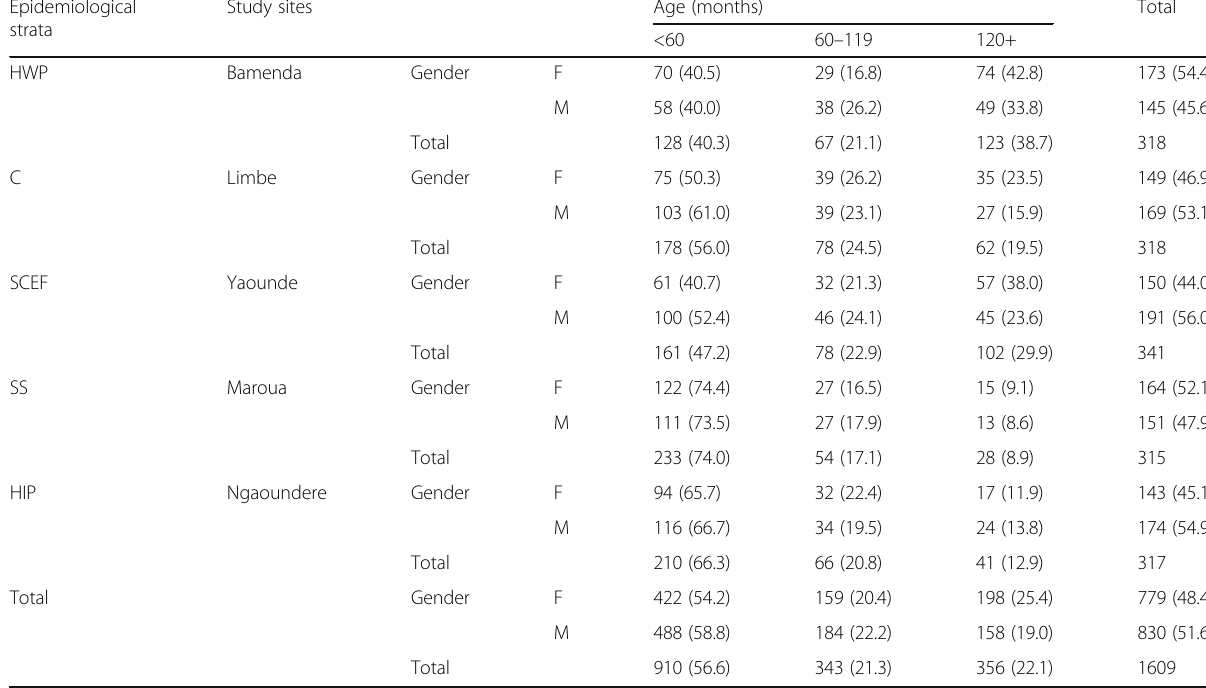
Table 1 Distribution of the study population with respect to age, gender and study site Epidemiological strata